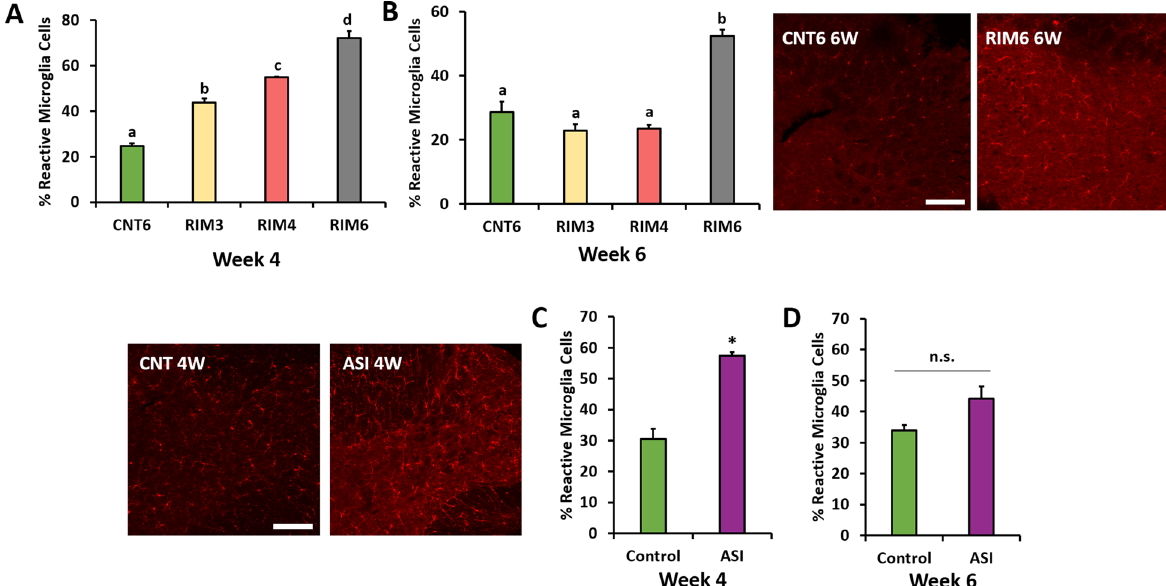
Figure 3. Spinal cord microgliosis in mice subjected to reserpine-induced myalgia and intramuscular acid saline solution injection. Representative histological images of IBA1-positive cells are presented around the figure. Reactive microglial cells showed shorter cytoplasmic extensions and an ameboid shape. Histograms show the percentage of reactive microglial cells in the RIM groups at (A) four and (B) six weeks postinduction and ASI after (C) four and (D) six weeks. Data are expressed as the mean ± SEM. a–d: Groups not sharing a letter showed significant differences, p < 0.05; * p < 0.05 significant decrease versus ASI-Control, by post hoc (Fig. 4C). In particular, 3 weeks postinduction, RIM3 ( p = 0.016), RIM4 ( p = 0.008) and RIM6 ( p = 0.001) showed a significant decrease in time spent in the center when compared with CNT6 (Mann–Whitney U-test). Subse- quently, while at 6 weeks after induction no difference was found between CNT6 and RIM3 ( p = 0.310), both RIM4 and RIM6 animal groups still showed a significant decrease in time spent in the center in comparison to controls (all p ’s < 0.032) (Fig. 4C). In contrast, no significant differences were found in the time spent in the center between the ASI animals and the control group at either 3 or 6 weeks after induction (Fig. 4D). In sum-